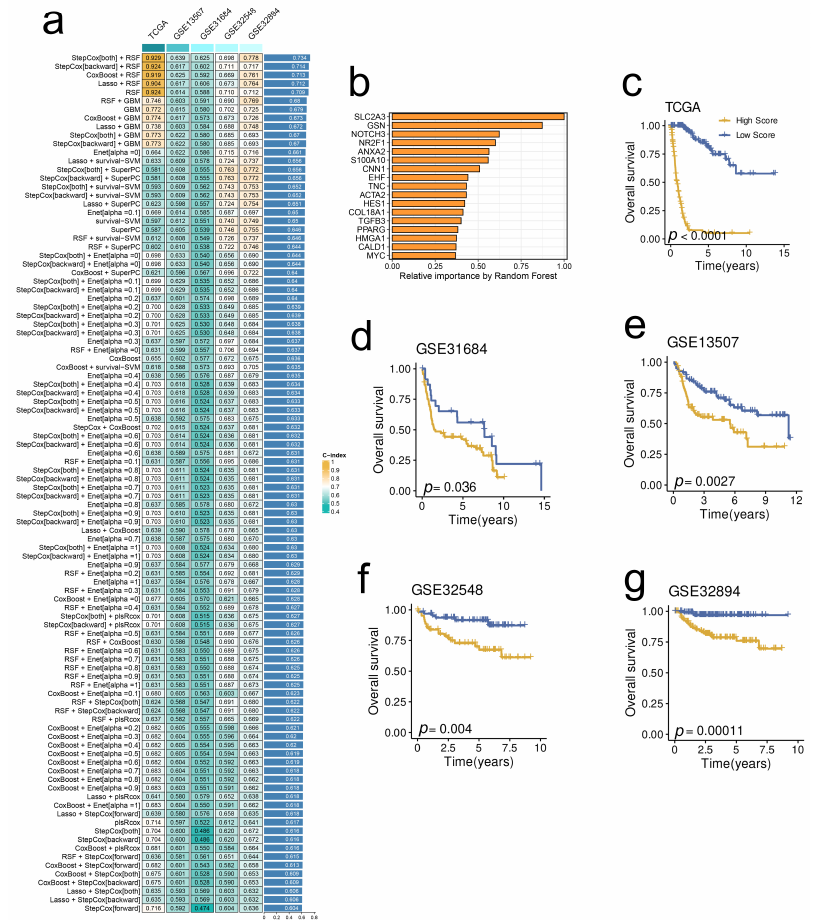
Figure 6. A prognostic model derived from the Stem. Sig. by an integrated machine-learning framework. ( a ) A total of 101 combinations of machine learning algorithms via a 10-fold cross-validation framework. The C-index of each model was calculated across validation datasets, including TCGA-BLCA, GSE13507, GSE31684, GSE32548, and GSE32894 datasets. ( b ) The importance of